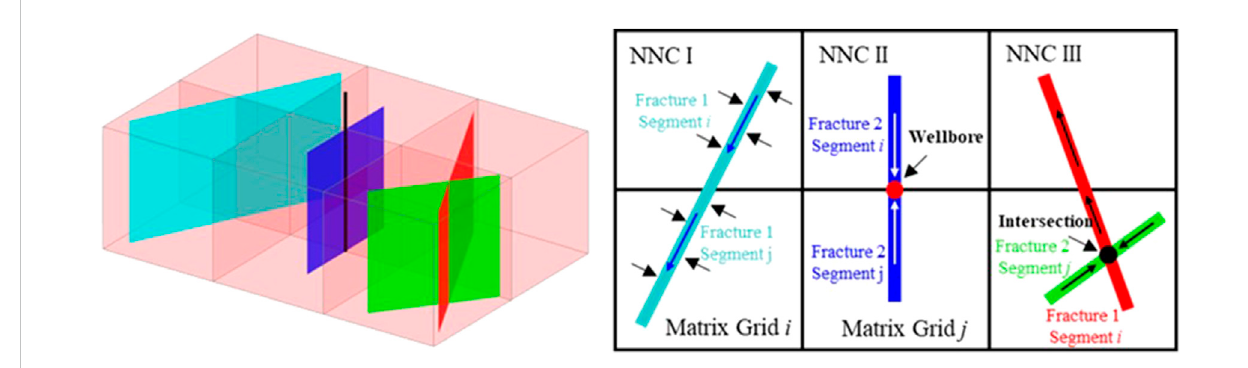
FIGURE 1 Schematic of the EDFM model for fractured hydrate